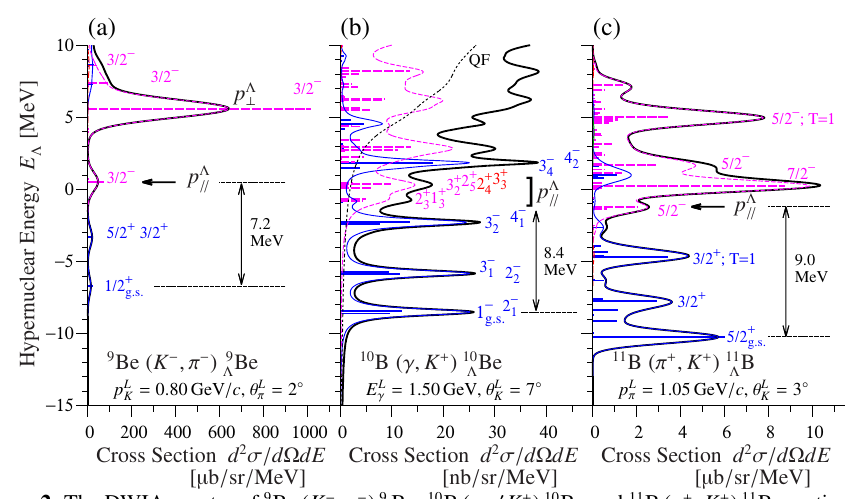
Figure 2. The DWIA spectra of 9 Be( K − ,π − ) 9 Λ Be, 10 B( e , e ′ K + ) 10 Λ Be and 11 B( π + , K + ) 11 Λ B